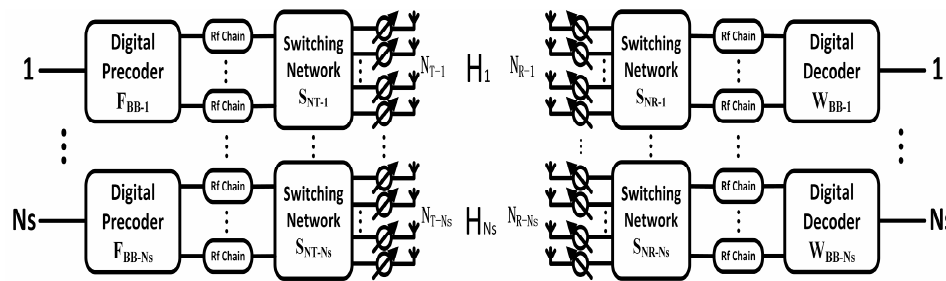
Figure 2. Hybrid precoding structure based on switching network.